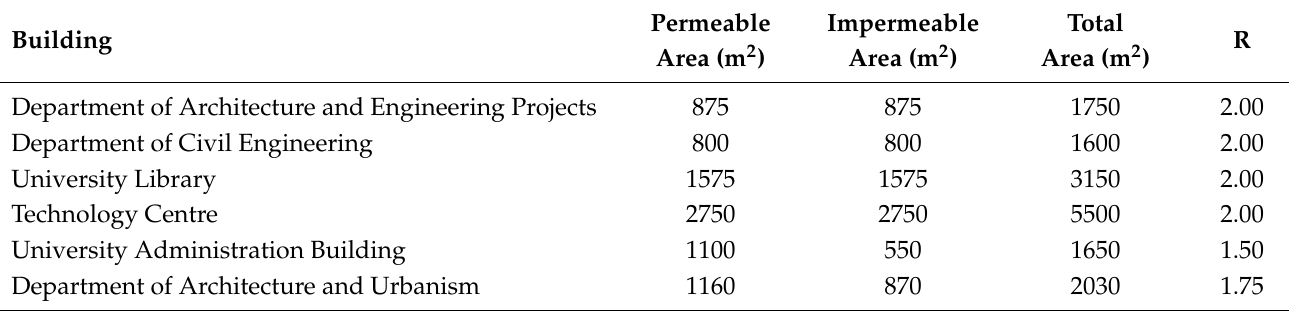
Table 7. Pavement areas and